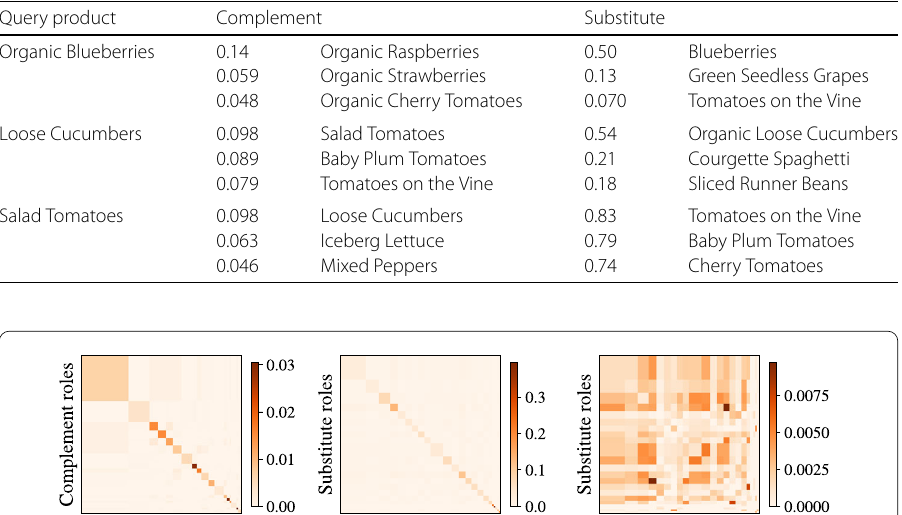
Table 1 Products of the three highest complementarity scores and substitutability scores with the query